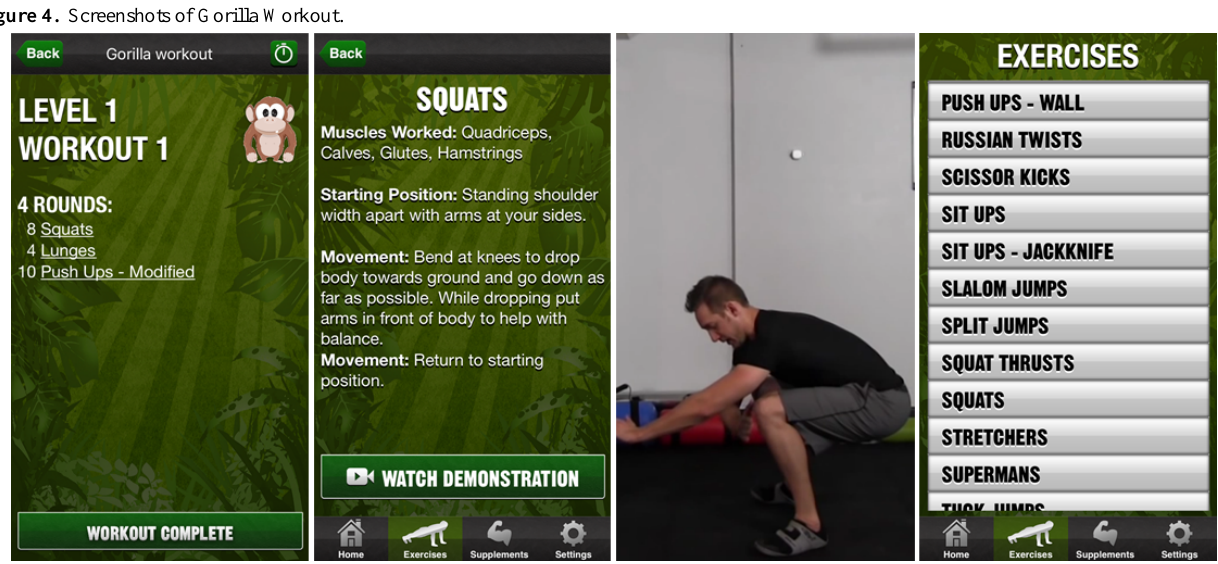
Figure 4. Screenshots of Gorilla